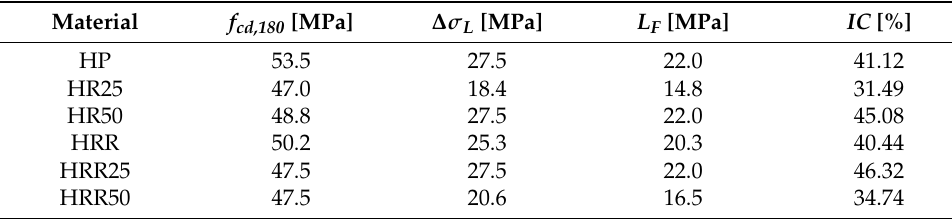
Table 7. Fatigue limit obtained from Locati Method.